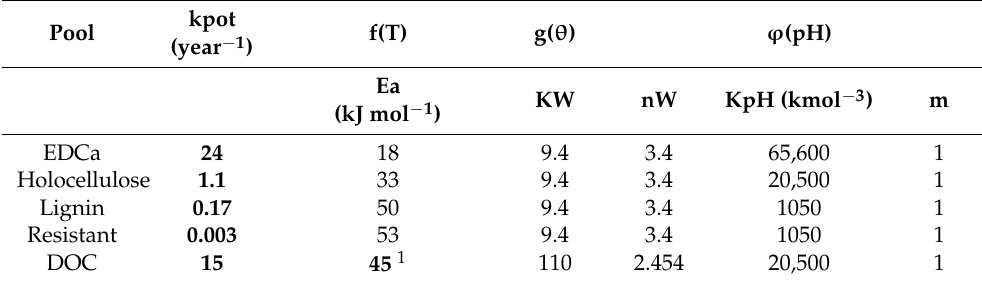
Table 1. Revised parameters regulating decomposition rates in ForSAFE. In bold: parameters modified from